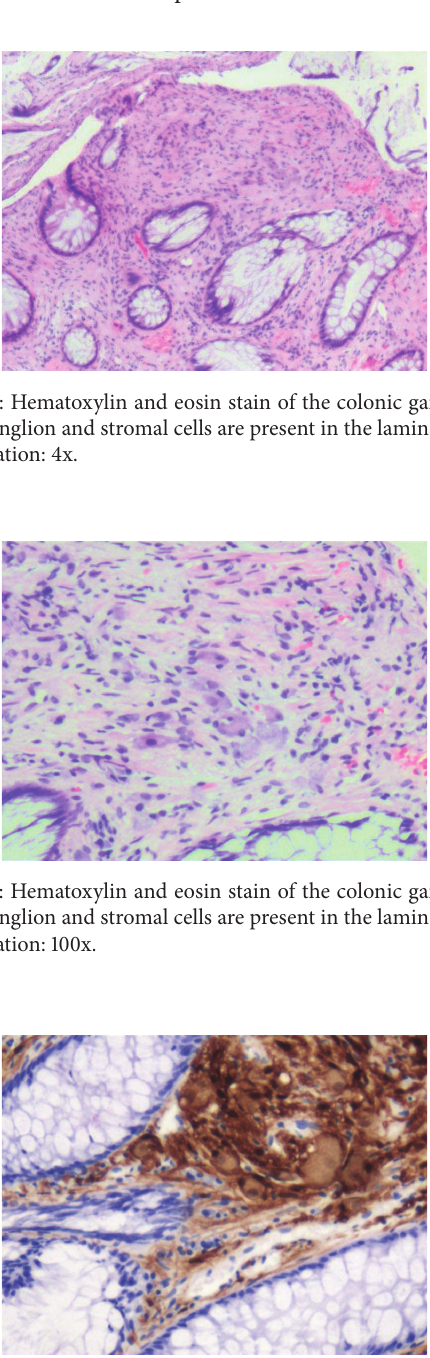
Figure 4: Immunohistochemical stain of the colonic ganglioneu- roma demonstrating S100 immunoreactivity. Magnification: